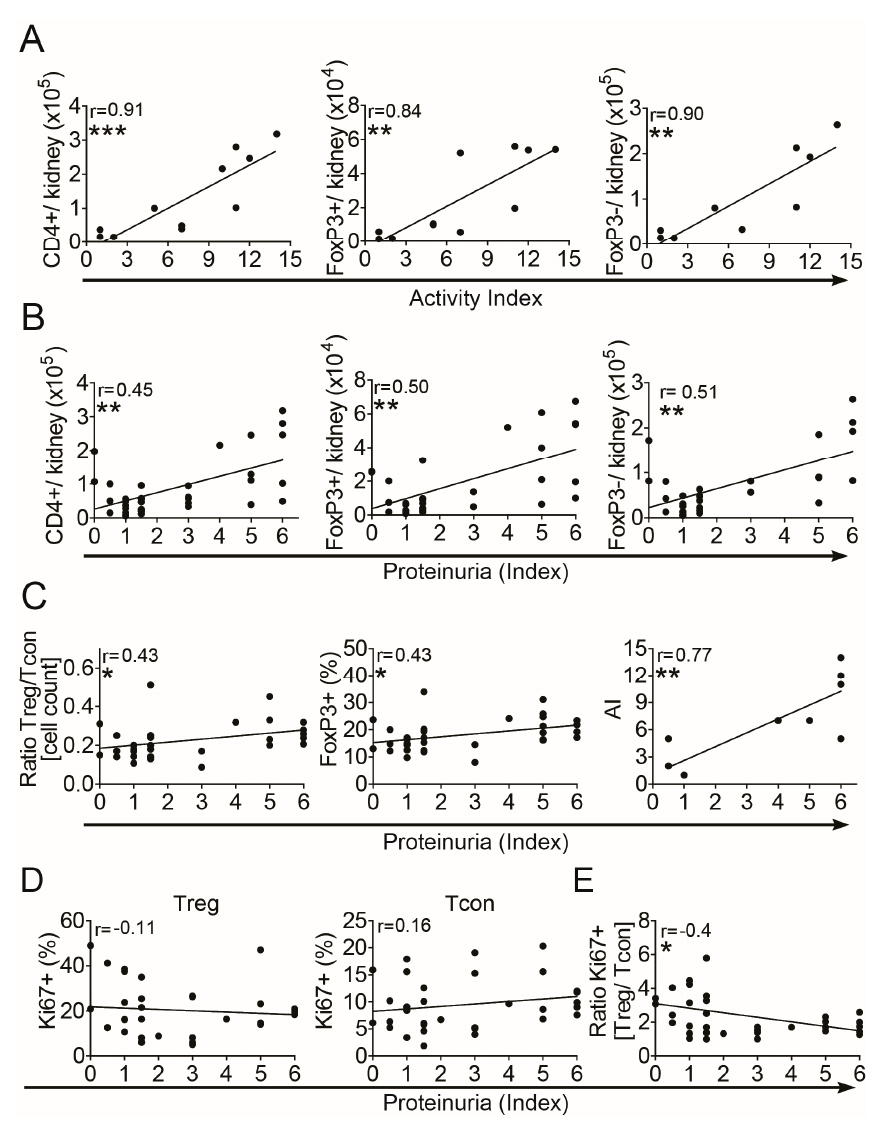
Figure 1. Progressive Treg/Tcon imbalance during progression of lupus nephritis. Cells from kidneys of (NZB × NZW) F1 mice at different disease stages were analyzed by flow cytometry. ( A , B ) Absolute numbers of total intrarenal CD4+ T cells, of intrarenal CD4+FoxP3+ Treg and of intrarenal CD4+FoxP3 − Tcon in correlation with the renal histomorphological activity index (AI) ( A ) and with the proteinuria index ( B ). ( C ) Graphs show the correlation of the calculated ratio between absolute numbers of CD4+FoxP3+ Treg and CD4+FoxP3 − Tcon (left graph), the correlation of the percentages of FoxP3+ cells among CD4+ T cells (middle graph) and the correlation of the AI with the proteinuria index (right graph). ( D ) The percentage of intrarenal Ki67+ cells among CD4+FoxP3+ Treg (left graph) and among CD4+FoxP3 − Tcon (right graph) is shown. ( E ) The calculated ratio between percentages of Ki67+ Treg and of Ki67+ Tcon in correlation with the proteinuria index is shown. Data are derived from one kidney of each mouse from two to five independent experiments ( n = 10 for correlations with AI; n = 28–30 for correlations with proteinuria index). Correlation analyses were performed by using Spearman’s rank correlation coefficients. Black lines indicate linear regression curves using Pearson analyses (* p < 0.05, ** p < 0.01 and *** p < 0.001).